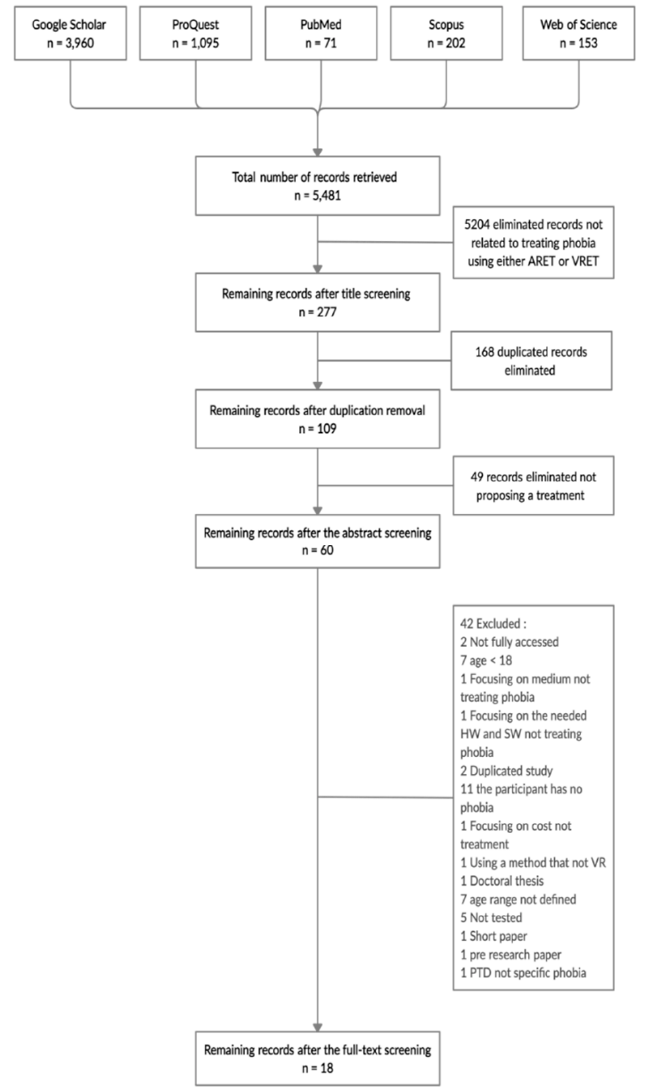
Figure 1. Systematic review search PRISMA.